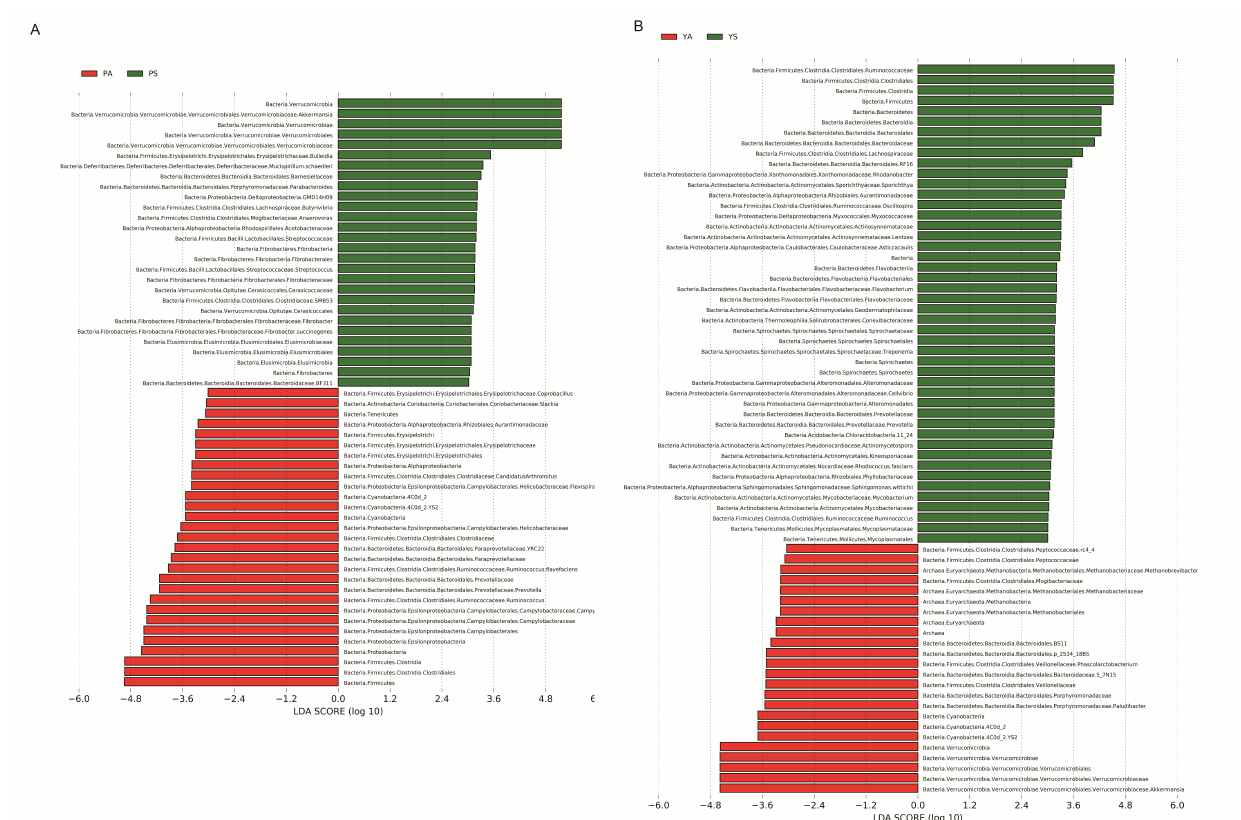
Figure 3. ( A ) Biomarkers of gut microbiota among different pika’s population in Lefse result. ( B ) Biomarkers of gut microbiota among different yak’s population in Lefse result. The “PA”: the pikas in the allopatric enclosure, “PS”: sympatric pikas with yaks, “YS”: sympatric yaks with pikas, and “YA”: yaks in allopatric